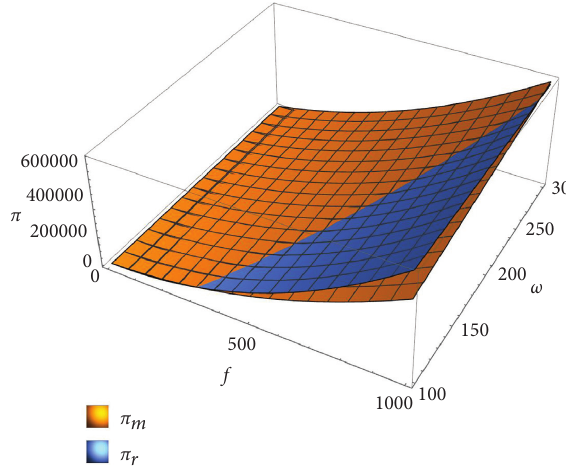
Figure 9: The changes of profits with f and ω .